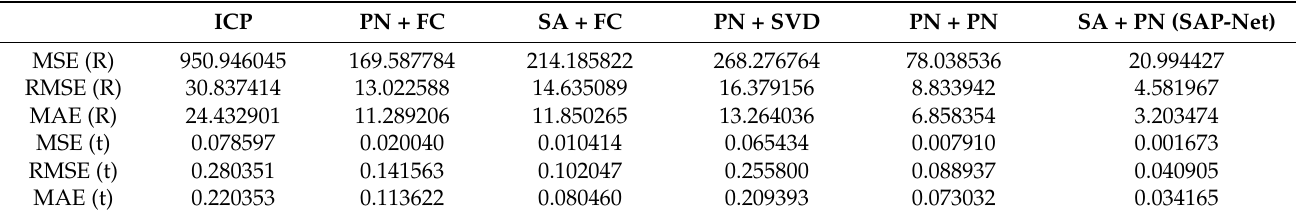
Table 5. Test with Gaussian